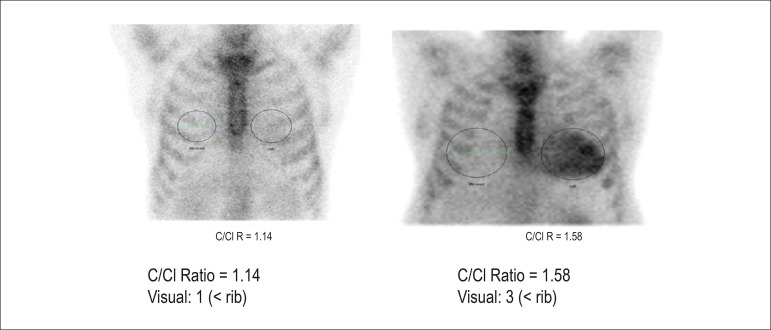
Quantification of uptake in planar imaging of anterior thorax scintigraphy with Pyrophosphate-99mTc. The image on the left represents a negative study, without uptake in the cardiac area. The image on the right represents a study positive for amyloidosis, with accentuated diffuse uptake in the left ventricle. For the purpose of quantification, circular regions of interest (ROI) have been drawn in both hemithoraxes, and the uptake ratio of the radiopharmaceutical between the ROI in the cardiac area (C) and the ROI in the contralateral (Cl) hemithorax. Results over 1.5 suggest TTR amyloidosis. The visual uptake score was equal to 1 in the image on the left and 3 in the image on the right.